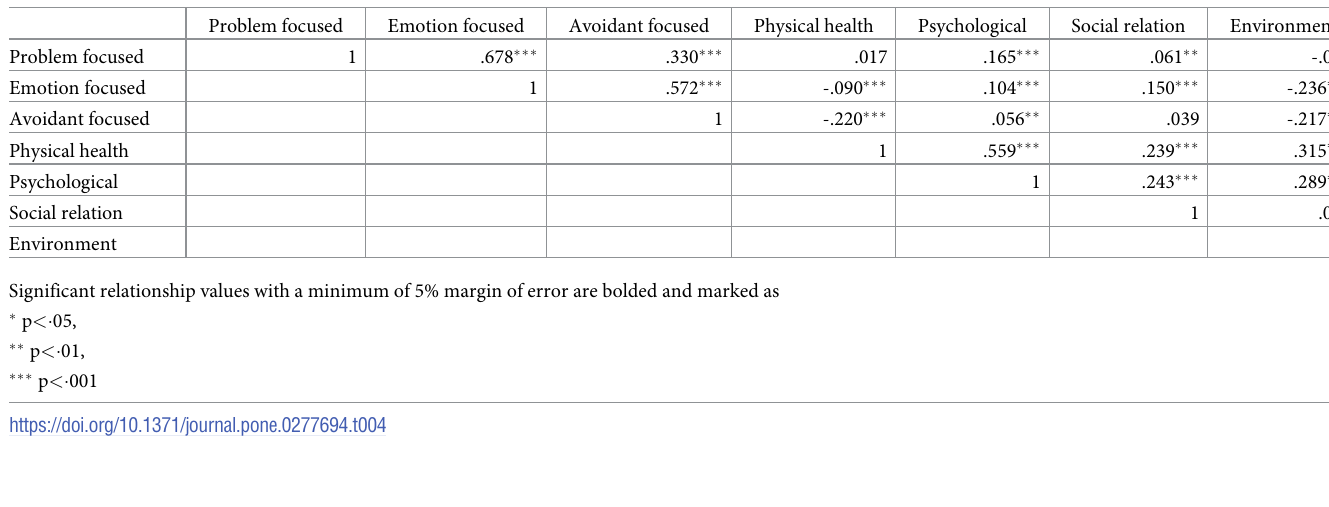
Table 4. Correlation between COPING and QoL by Pearson correlation